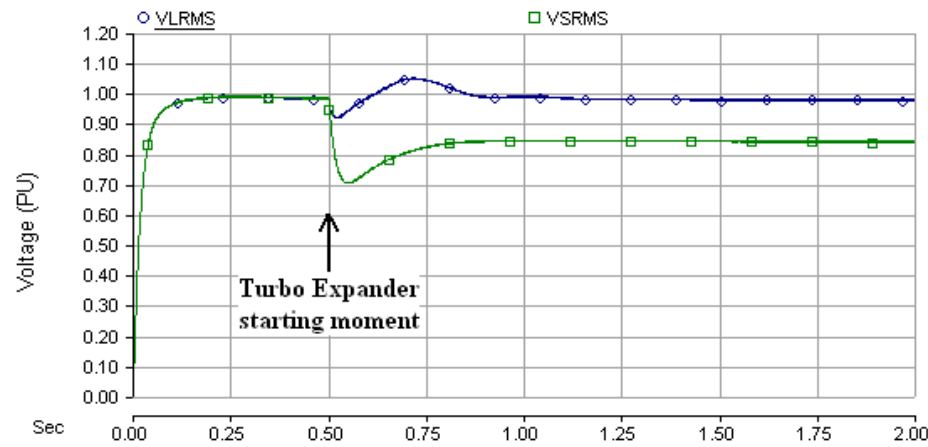
Figure 5. Supply and compensated load side voltage (VSRMS and VLRMS) in the turbo-expander start-up with the DVR compensator.